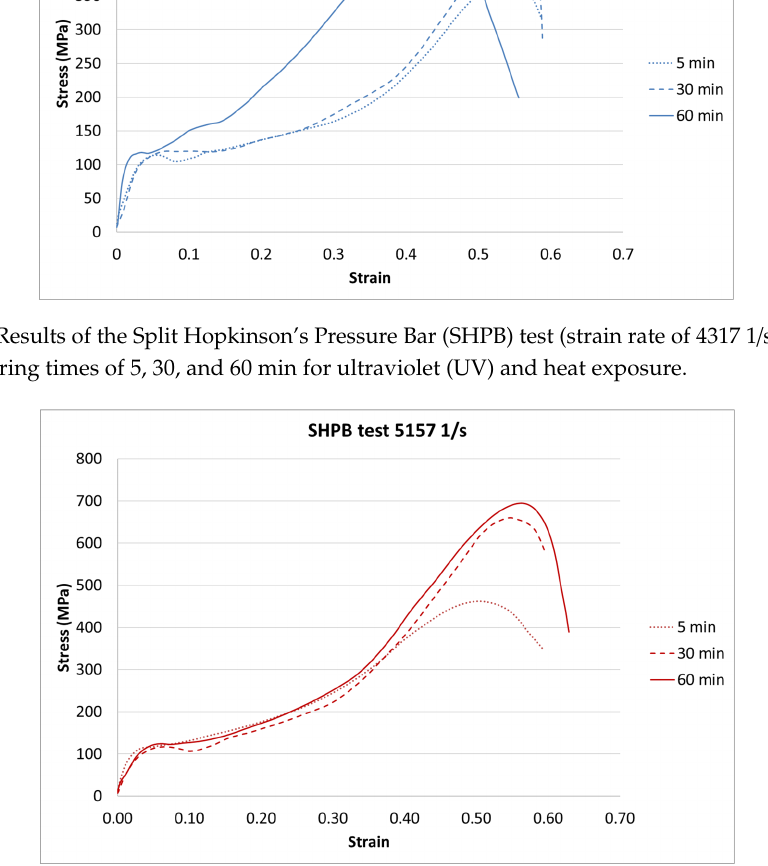
Figure 14. Results of the SHPB test (strain rate of 5157 1/s) of durable resin for curing times of 5, 30, and 60 min for UV and heat exposure.